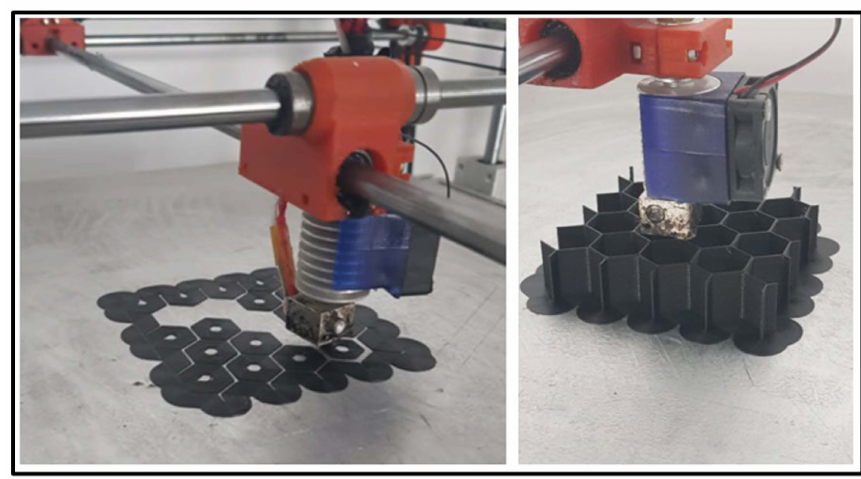
Figure 8. Honeycomb compression specimen realized by FDM manufacturing.